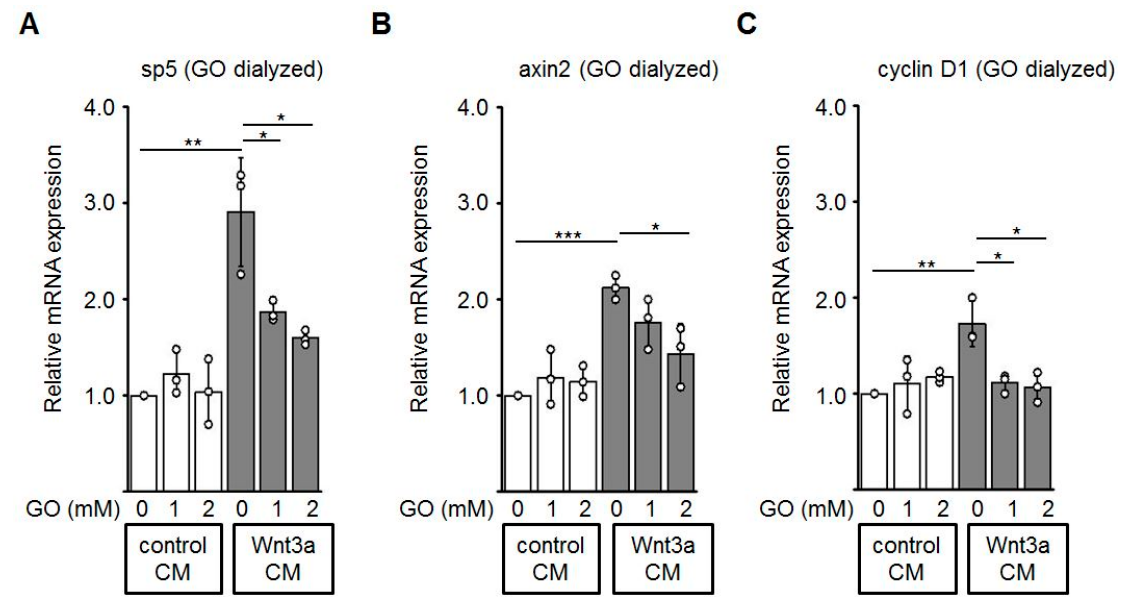
Figure 7. Expression of the endogenous Wnt target genes sp5 ( A ), axin2 ( B ), and cyclin D1 ( C ) is down-regulated in HEK-293 cells incubated with glycated Wnt3a CM (GO dialyzed). The graphs show mean values ± SD. Circles represent individual experiments. n ≥ 3, * p < 0.05, ** p <